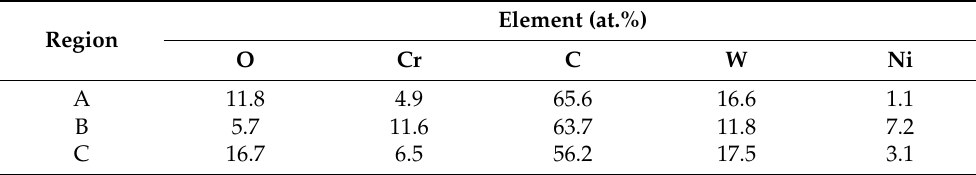
Table 2. Composition of elements in different regions of WC-Cr 3 C 2 -Ni coating after CSE for 6 h in 3.5 wt.% SCM under different FVs and SCs. Element (at.%) Region O Cr C W